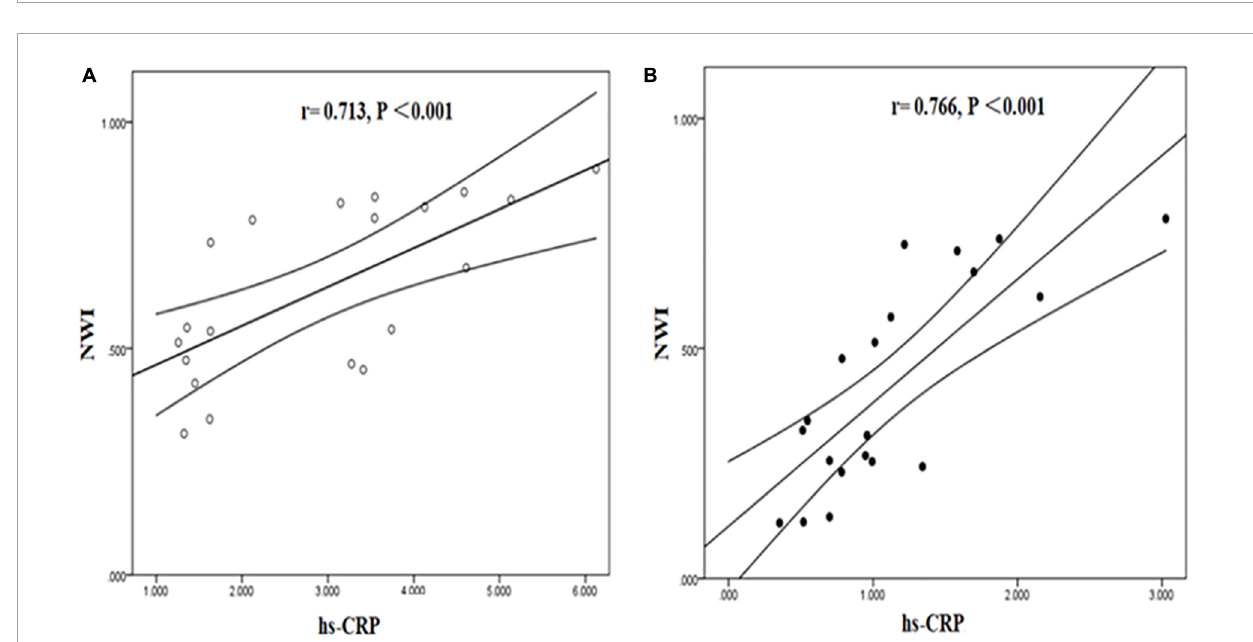
FIGURE8 Correlation between hs-CRP and NWI in symptomatic and asymptomatic patients. The correlation between hs-CRP and NWI values was significantly positive in symptomatic (A) and asymptomatic group (B)